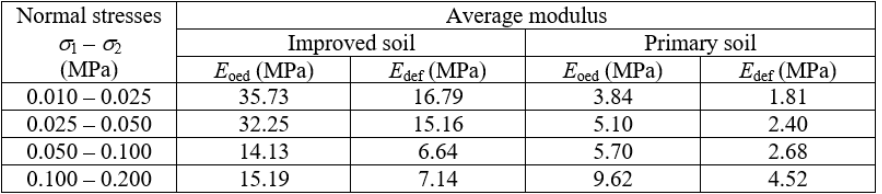
Table 1. Deformation modulus of soils determined from compression